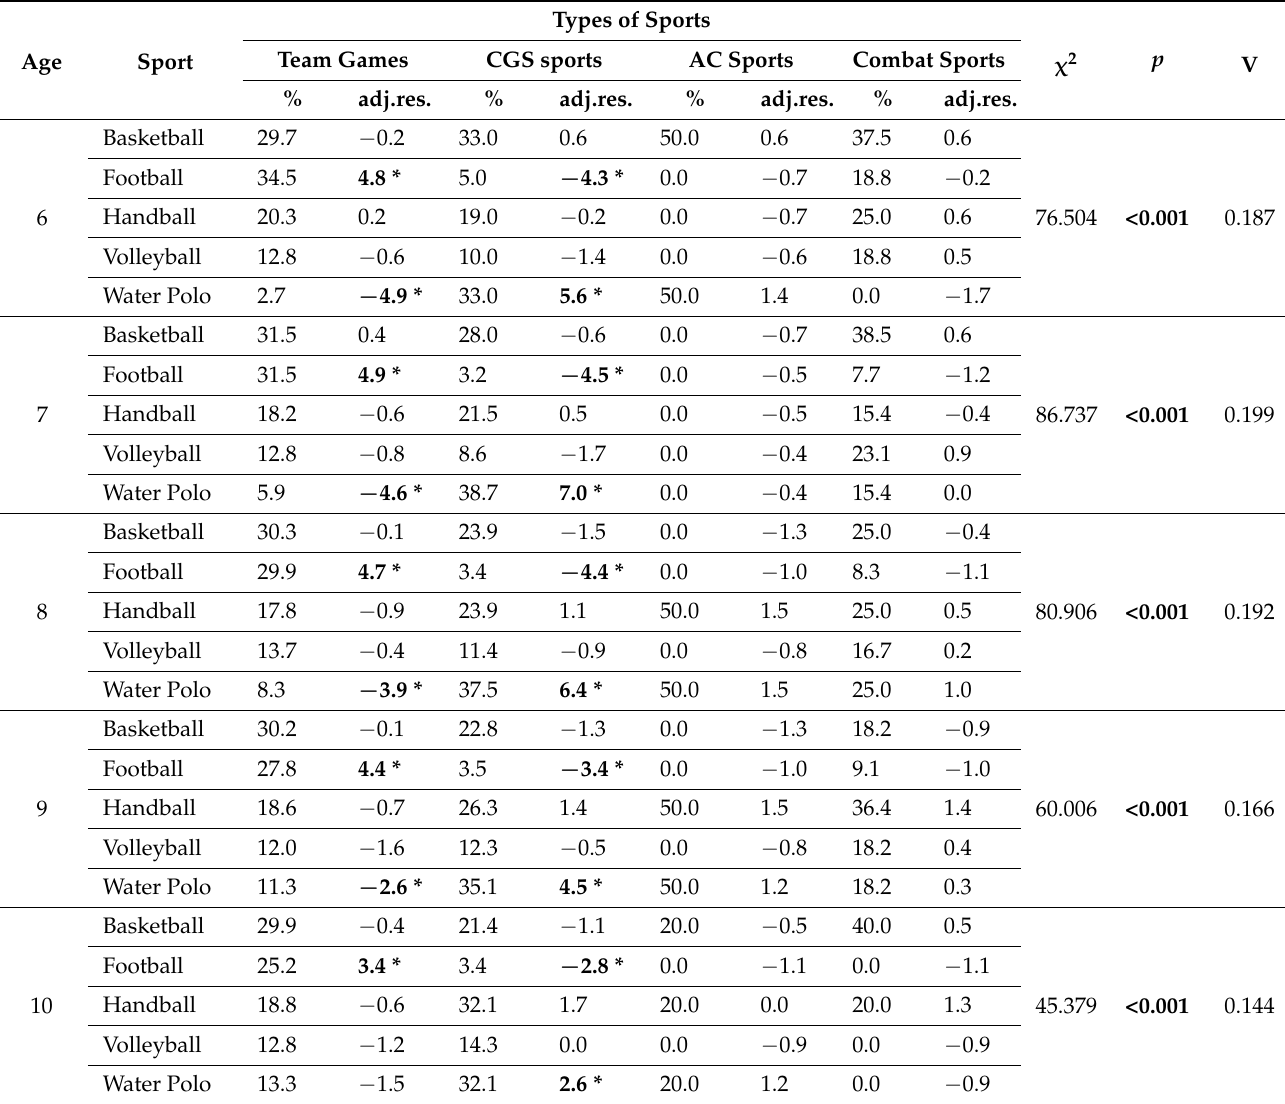
Table 3. Chi-square statistics (% and adjusted standardised residuals) for the type of sports practised according to